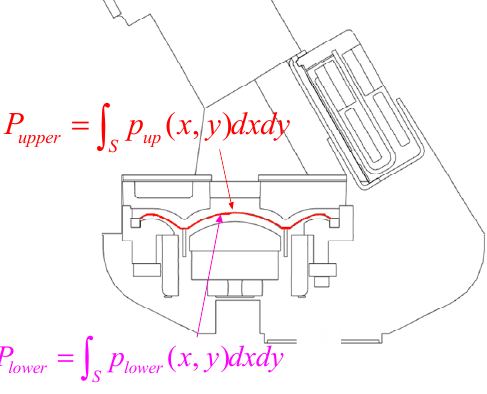
Figure 8. Air pressure force definition.